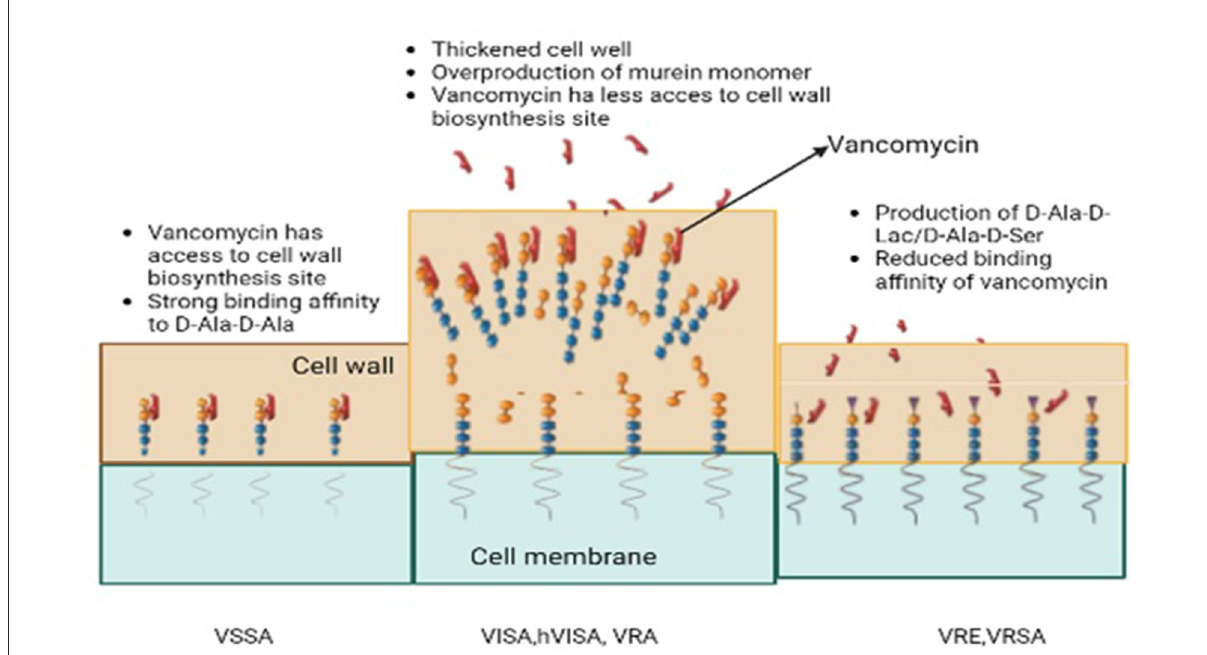
FIGURE3 The development of acquired resistance; Vancomycin-resistant S. aureus (VRSA), Vancomycin-resistant Enterococci (VRE), Vancomycin susceptible S. aureus, Vancomycin intermediate S. aureus (VISA), Hetero-vancomycin intermediate S. aureus